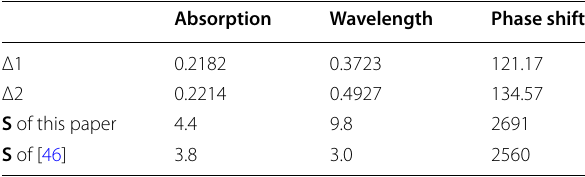
1.0 eV. c Three-dimensional = 2, n sur 1 = =